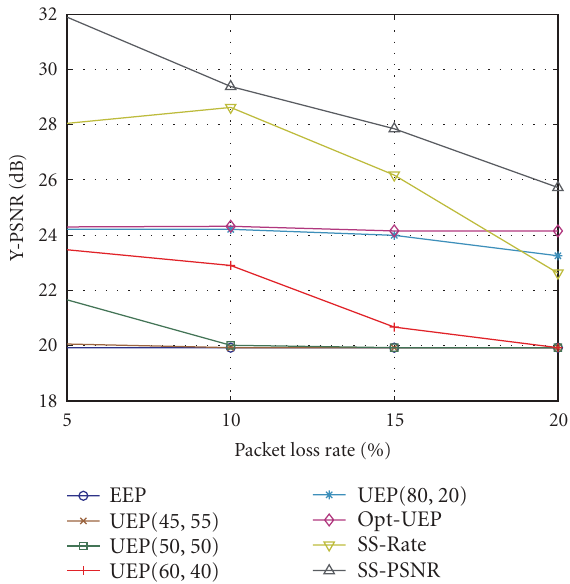
Figure 6: PSNR versus data rate at PLR of 10% for the “Football” sequence—uniform loss.